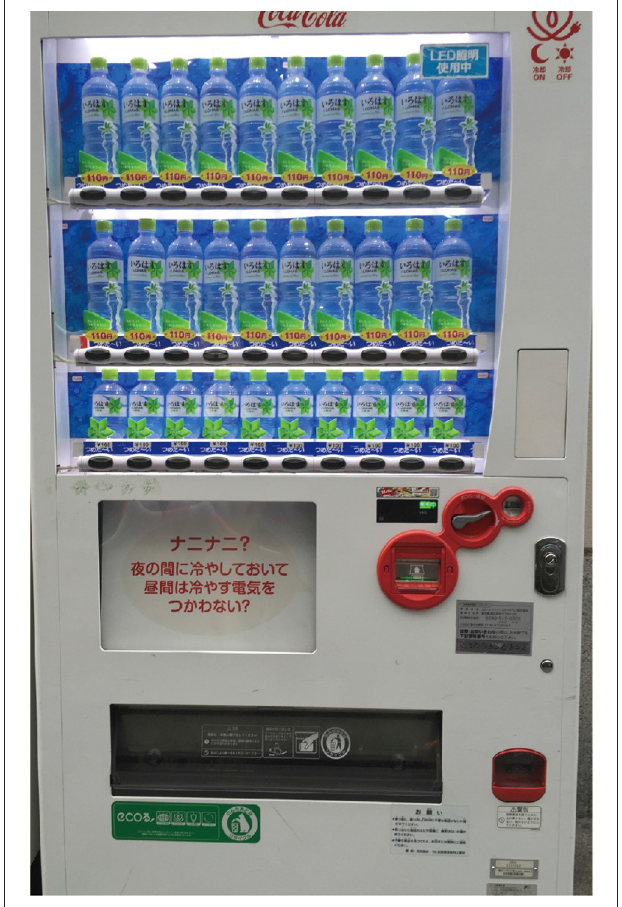
FIGURE 1 | A vending machine in